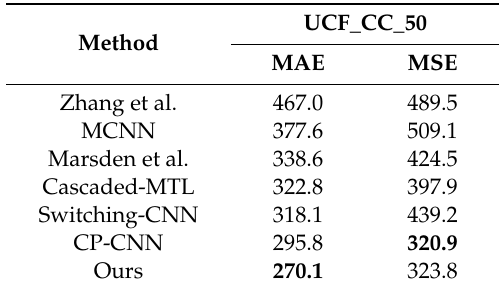
Figure 7. ( a , b ) are two sample images in UCF_CC_50 dataset. ( c , d ) are their density map generated by DSA-CNN for two images, respectively. Table 4. The comparisons in UCF_CC_50 dataset.